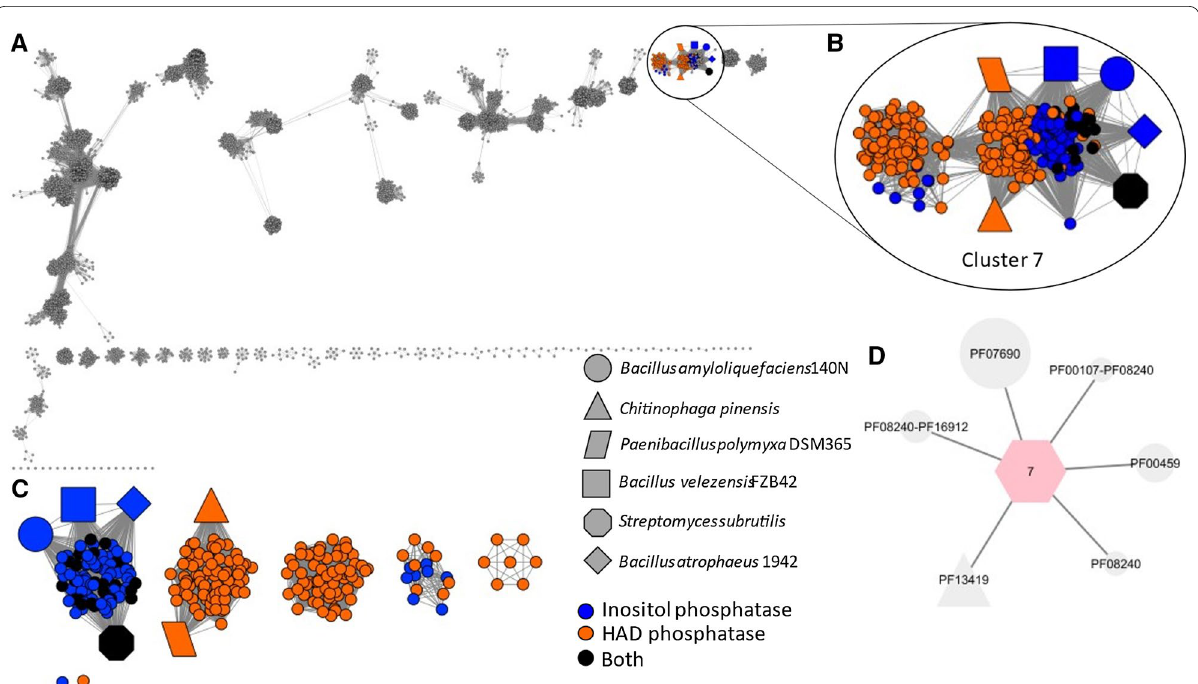
Fig. 3 A Aminotransferase SSN with an alignment score threshold of 40%. The nodes with neighboring dehydrogenase and phosphatase genes are colored based on the PFAM of phosphatase. B SSN containing only the 3GC nodes. C Aminotransferase SSN with an alignment score threshold of 50% containing only the 3GC nodes. D GNN for cluster 7; Known azasugar producers are assigned the following corresponding shapes: Parallelogram: P. polmyxa DSM365, Triangle: C. pinensis DSM2588, square: B. velezensis FZB42, diamond: B. atrophaeus 1942, and large circle: B. amyloliquefaciens 140N, Octagon: S.